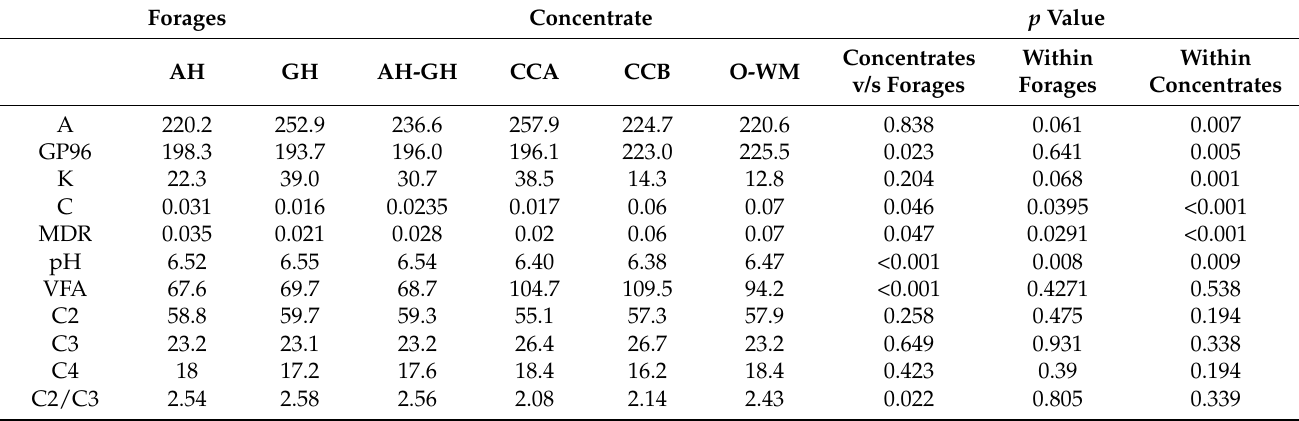
Table 2. In vitro GP parameters and concentrations of volatile fatty acids produced in the fermen- tation of the pure ingredients used for the experimental diets.